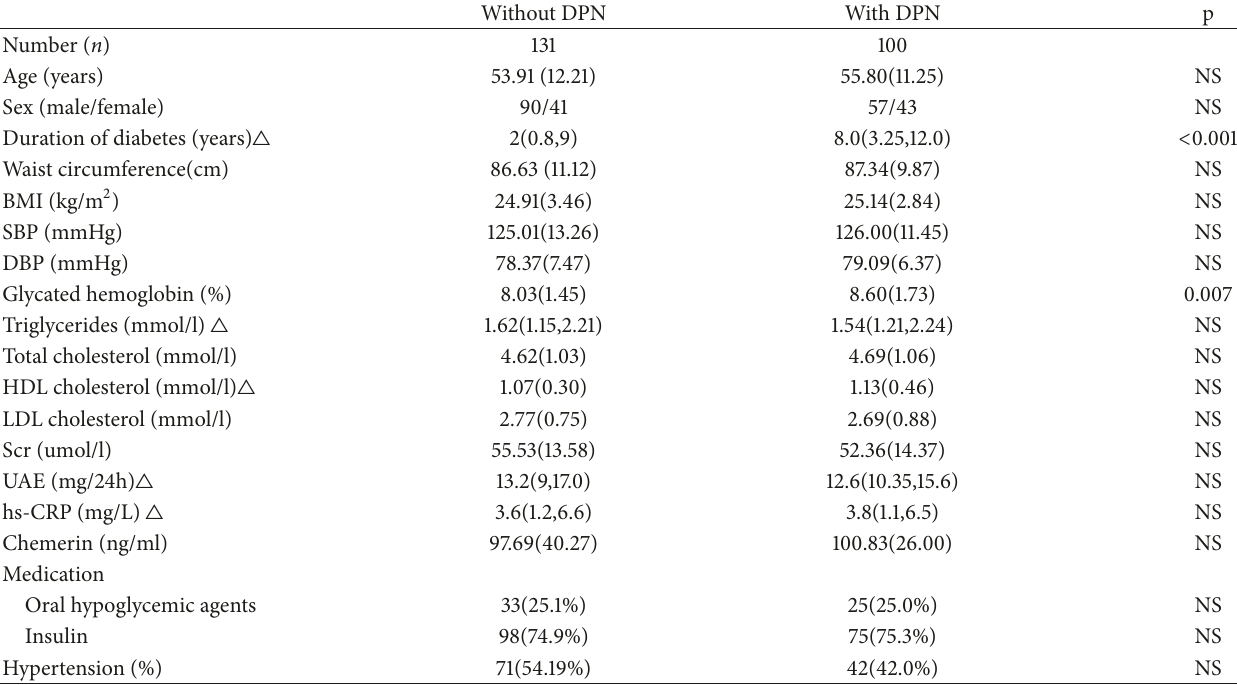
NumericalvariablesareexpressedasthemeanwithSDandmedian(interquartilerange).Categoricalvariableswerepresentedasnumber(percentage).P-value for difference between the groups was calculated from the analysis of Student’s t